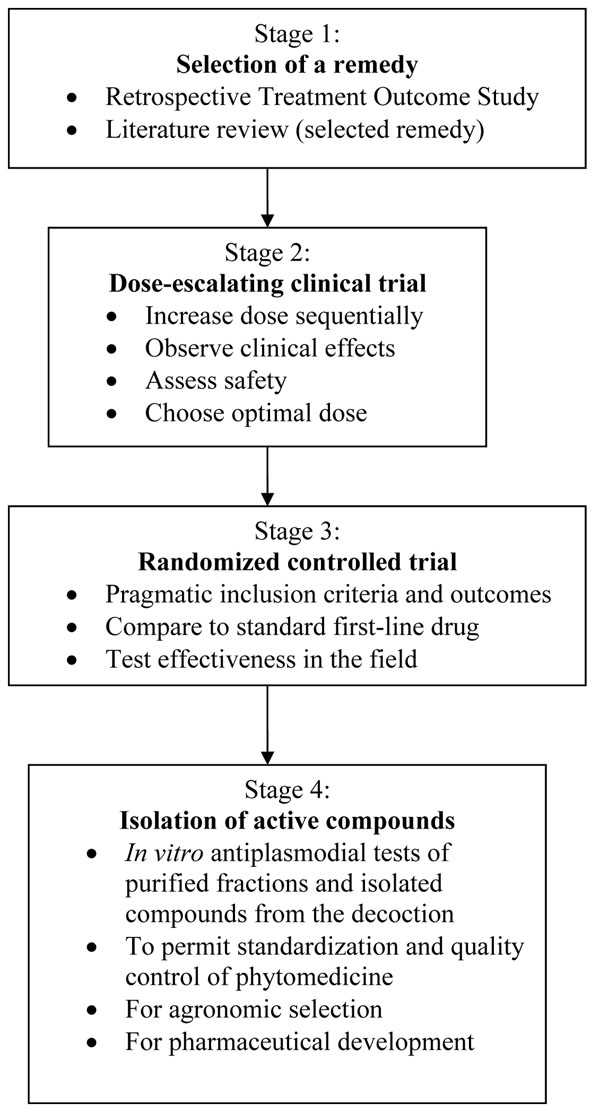
Summary of the methodology used to develop an anti-malarial phytomedicine by “reverse pharmacology”